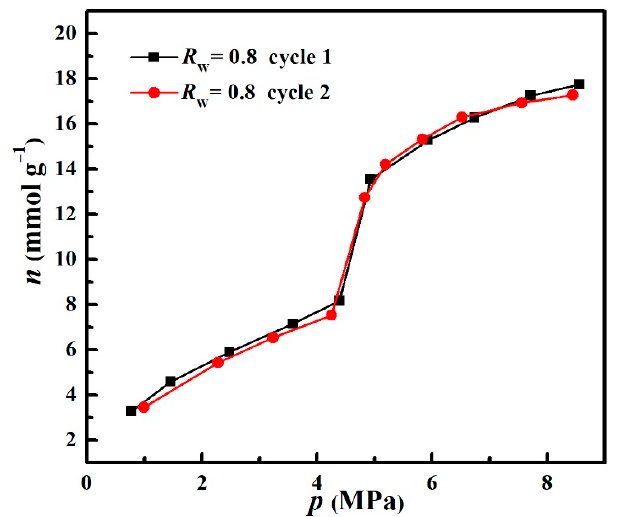
Figure 9. Methane adsorption isotherms at 275 K in the wet, hollow ZIF ‐ 8 with R W of 0.8 after different cycles.